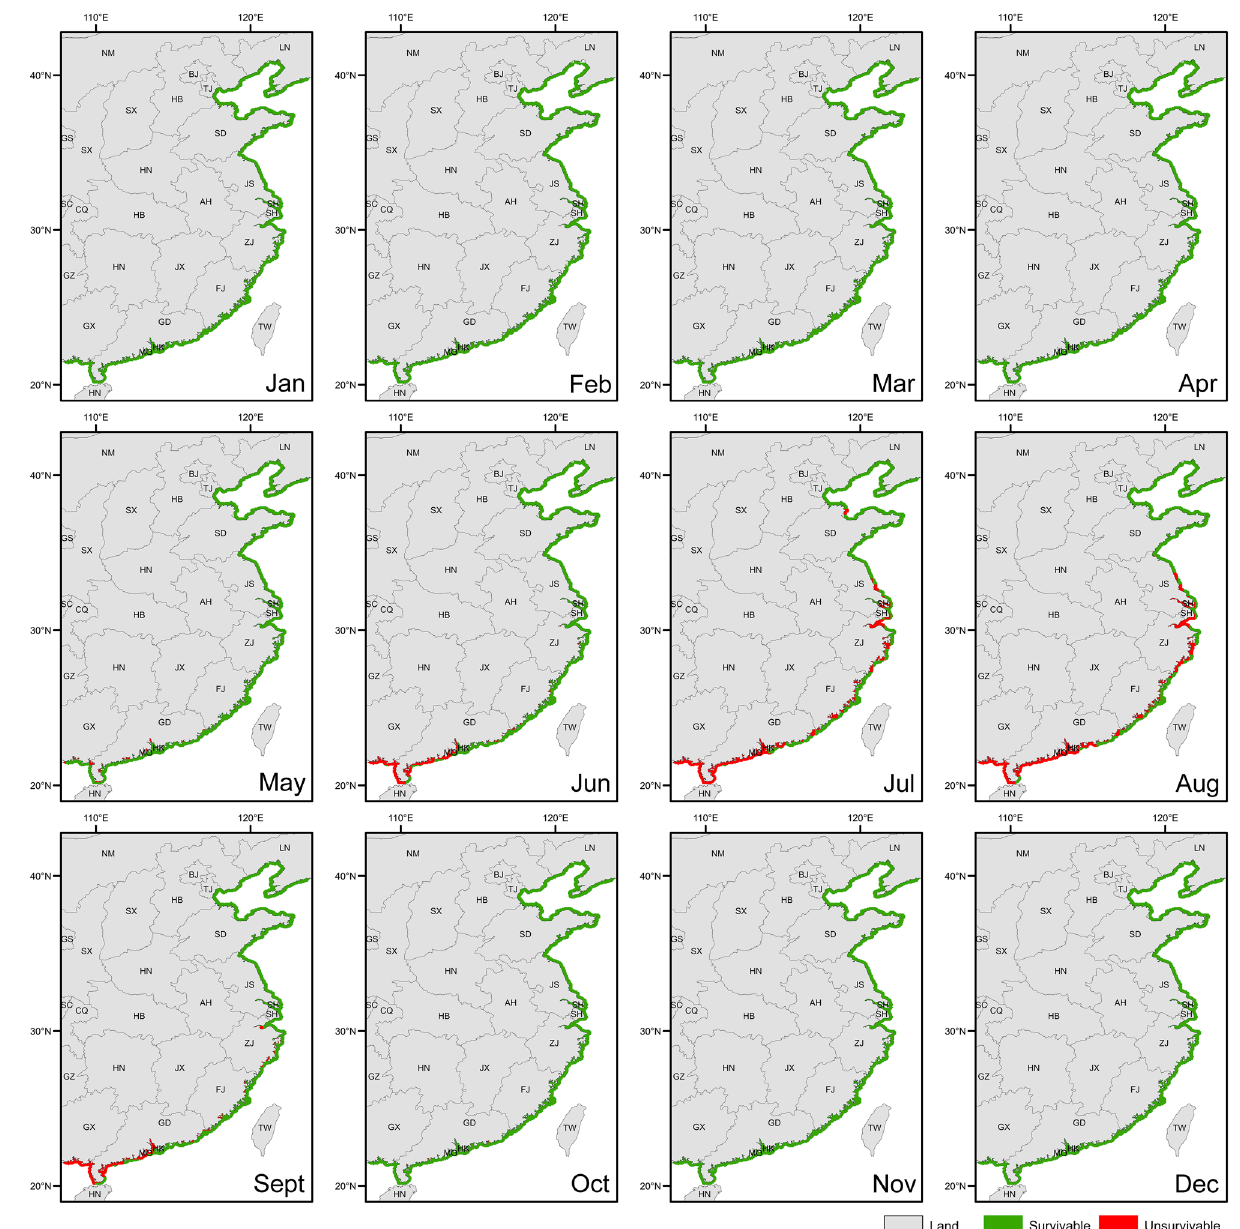
Figure 1. Maps of survivable areas and non-survivable areas for Apostichopus japonicus in China. The gray part is the land. The coastal areas marked in green indicate that sea surface temperatures are in the range where A. japonicus can survive. The red indicates the sea surface temperatures that exceed the tolerance of A. japonicus